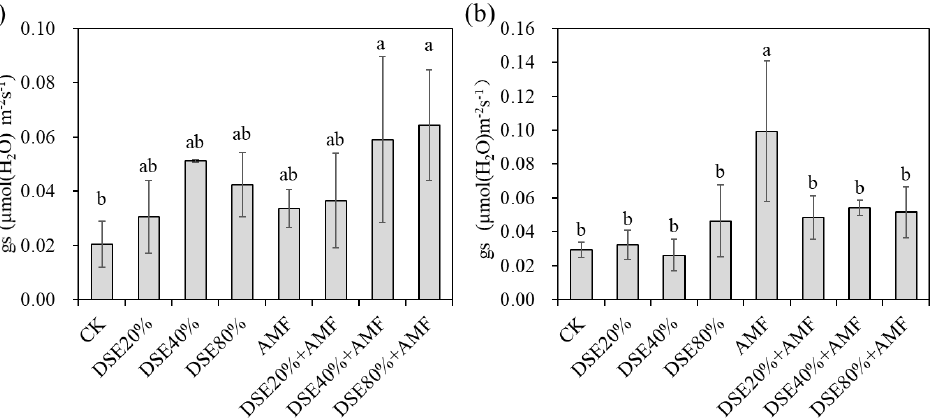
Figure 4. Stomatal conductance (gs) of plants undergoing different treatments on ( a ) the 44th day and ( b ) the 57th day. Control (CK), treatments with sterilized DSE and AMF; DSE20%, 2 × 10 5 CFU mL −1 of DSE with sterilized AMF; DSE40%, 4 × 10 5 CFU mL −1 of DSE with sterilized AMF; DSE80%, 8 × 10 5 CFU mL −1 of DSE with sterilized AMF; AMF, sterilized DSE with AMF; DSE20% + AMF → DSE80% + AMF, different concentration of DSE and AMF. The different letters above the columns are significantly different at p < 0.05.